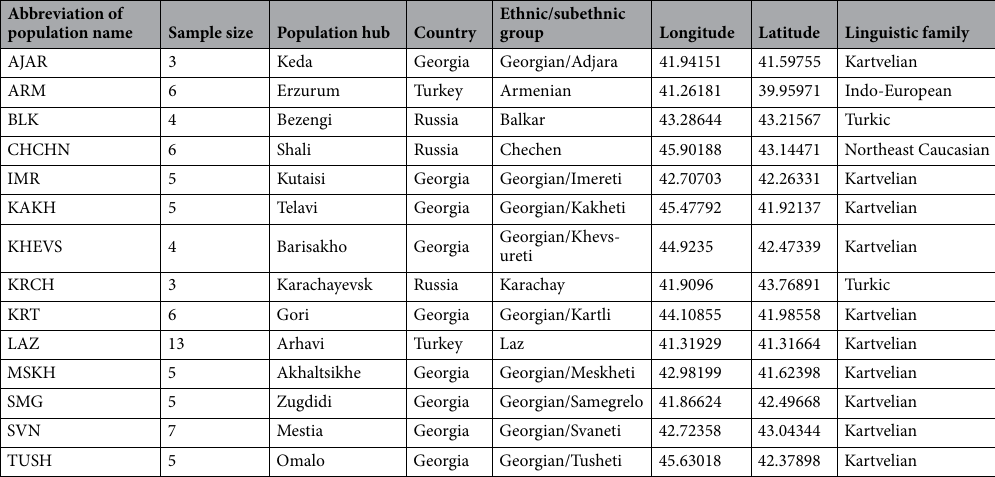
Table 1. Modern study populations of the Caucasus. Latitude and longitude georeference population